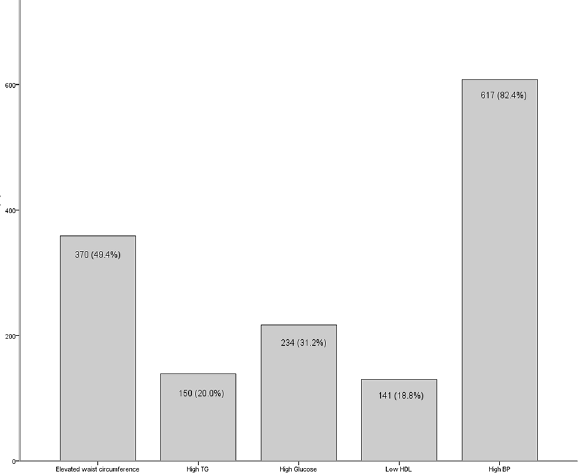
Fig 1. Proportion of participants with each component of the MetS. (A) TG = triglycerides. HDL = high- density lipoprotein cholesterol. BP = blood